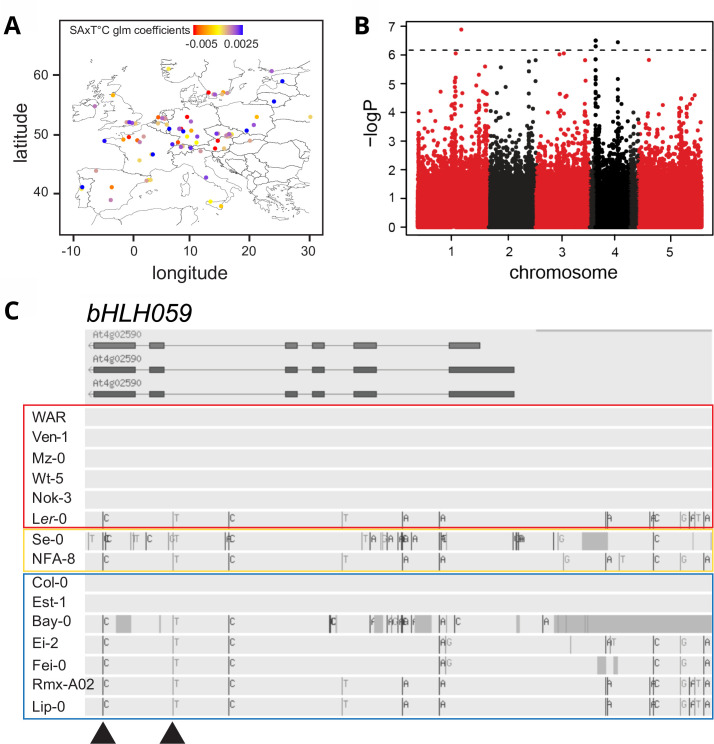
Distribution and genetic architecture of SA regulation by temperature in A. thaliana.A) Geographical distribution of 78 A. thaliana accessions from Europe, representing 75% of phenotyped accessions. Dot colours indicate phenotypes of SA regulation by temperature according to coefficients of our glm model. Colour scale represents accessions displaying higher SA contents at 22°C than at 16°C in red, equal SA contents in yellow and higher SA contents at 16°C than at 22°C in blue. B) Manhattan plot of association mapping with 99 A. thaliana accessions for SA regulation by temperature according to GWAPP using the coefficients of our glm model. Each dot represents a single nucleotide polymorphism and the dashed horizontal line indicates significant linkage disequilibrium threshold after Bonferroni multiple testing correction. C)
bHLH059 haplotypes according to Tair10 genome browser of accessions with extreme and intermediate total SA x T°C phenotypes. Colour blocks indicate phenogroups as displayed in phenotype distribution map in Fig 5A. Arrows indicate significant SNPs associated with total SA x T°C phenotype considered by GWAPP.